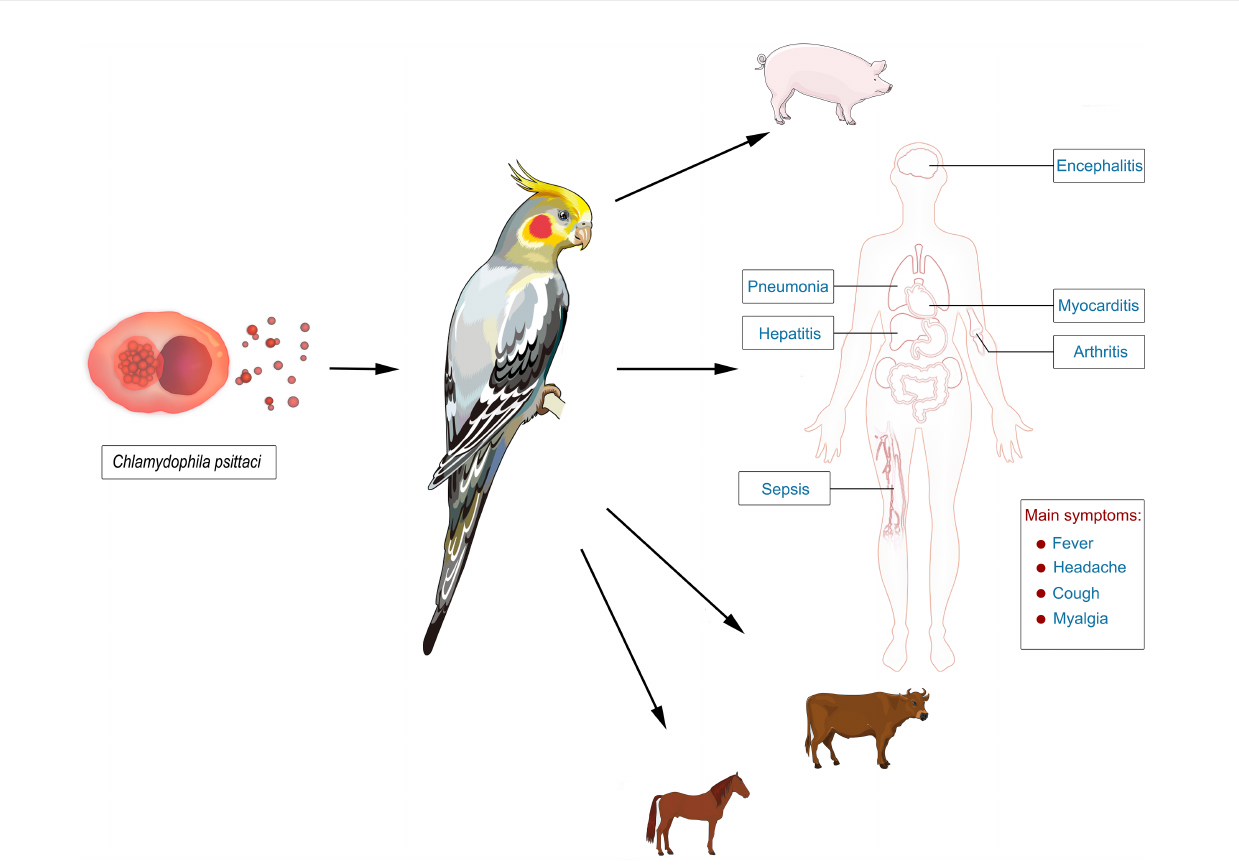
FIGURE 1 | The epidemiology of psittacosis and its manifestations in infected persons. Psittacosis is a zoonotic disease, and birds are the major source of infection. The pathogen, Chlamydophila psittaci , can infect multiple organs of the body and cause pneumonia, septic shock, and multiple-organ failure. The typical clinical symptoms include fever, headache, cough, and